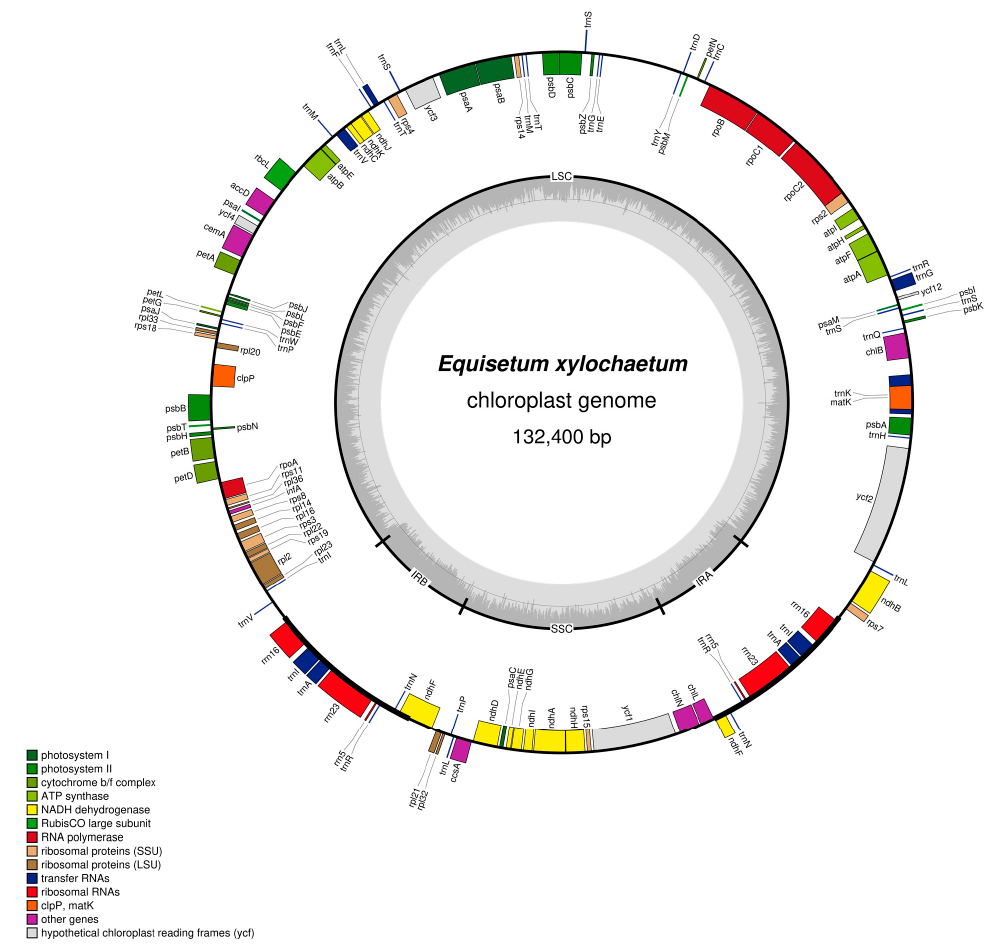
Figure 1. Circular map of the Equisetum xylochaetum plastid genome, NCBI accession MW282958, drawn by OGDRAW version 1.3.1 [10]. Genes positioned on the outside of the map are transcribed counterclockwise and those inside the map are transcribed clockwise. The thick lines indicate the extent of the inverted repeat regions. Table 2. Protein-coding gene content and introns of Equisetum plastid genomes. Comparison showed percent identity and size of the gene and its derived